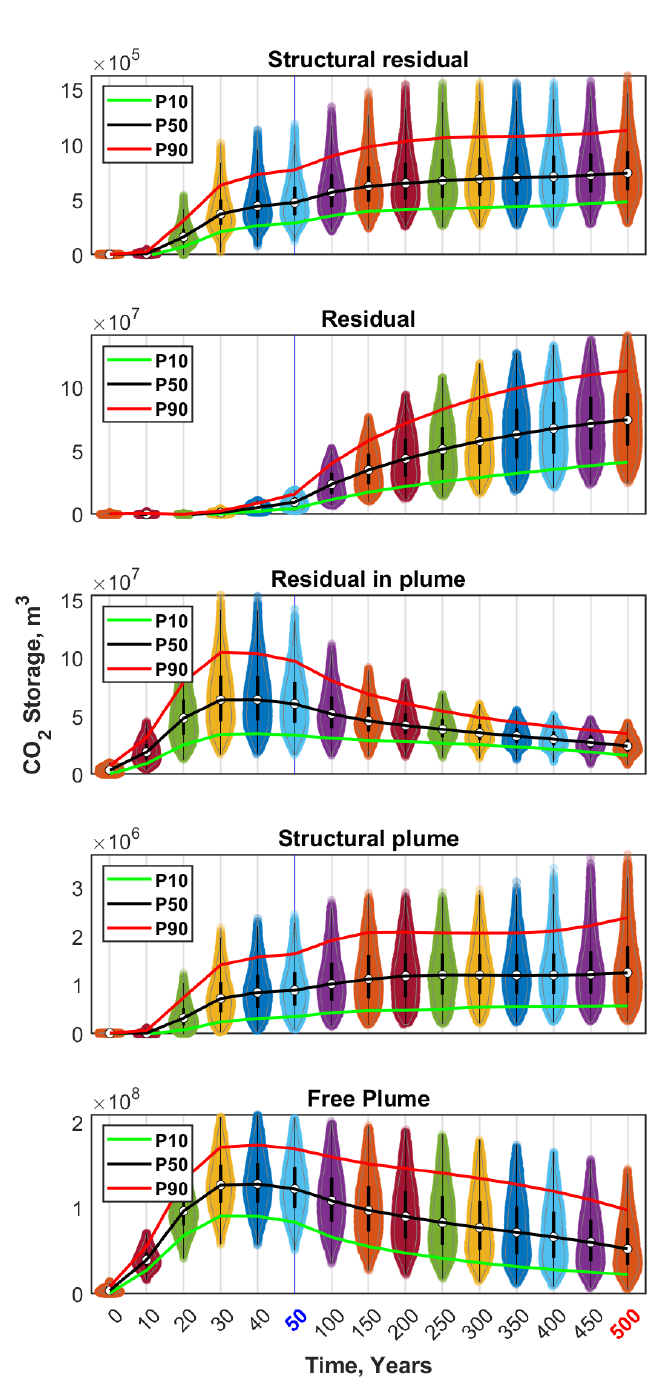
Figure 9. Uncertainty analysis based on 5000 Monte Carlo simulations for time-series outputs.